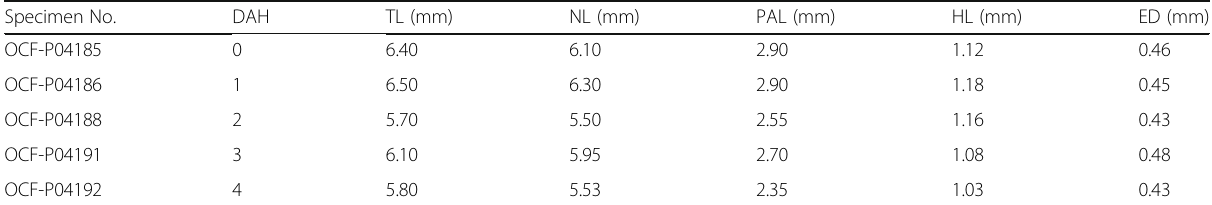
Table 1 Measurements of larvae obtained from the first artificial insemination of Regalecus russelii Specimen No.